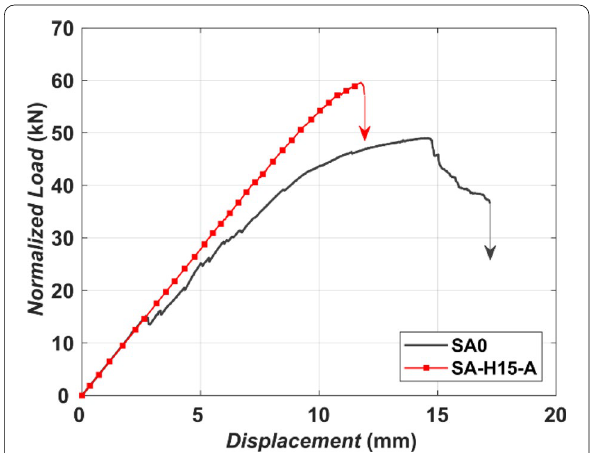
Fig. 8 Load–deflection curves of the specimens SA0 and